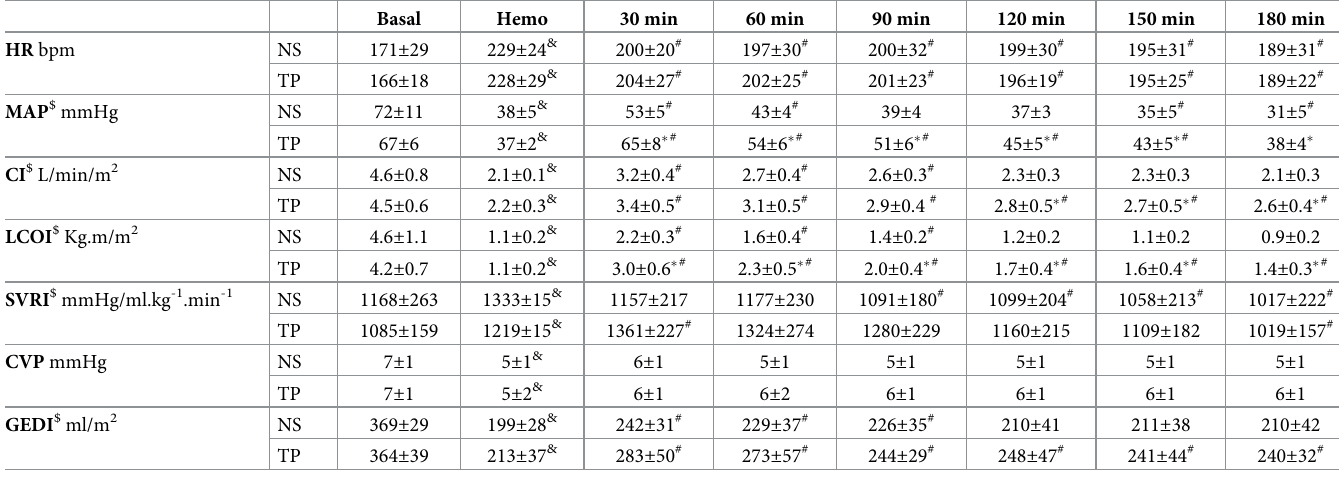
Table 1. Hemodynamic parameters.